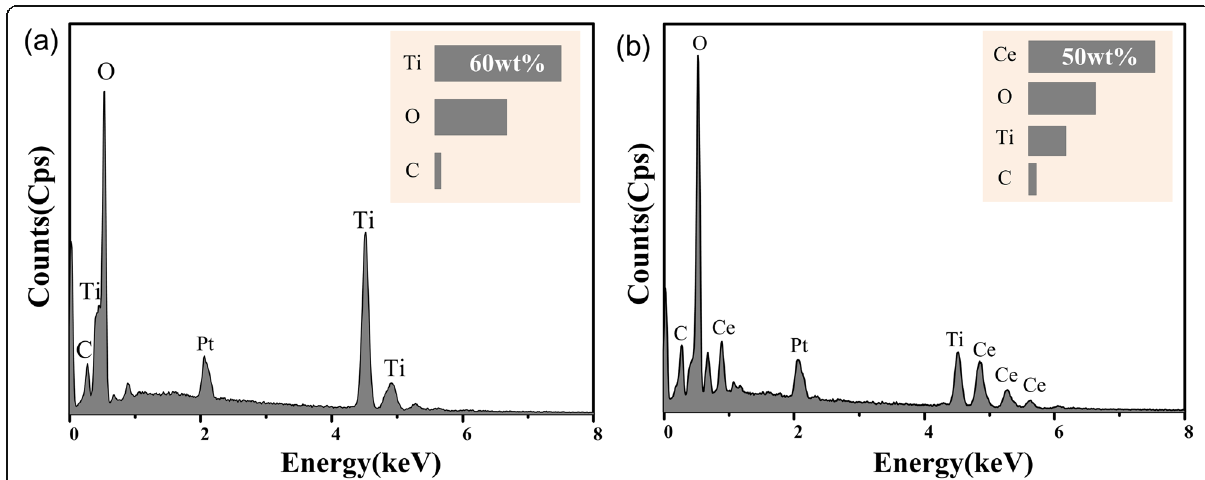
Fig. 6 EDS results of a pure TiO 2 NTs and b CeO 2 /TiO 2 heterojunction, showing the existence of element Ti, Ce, and O after loading Ce(NO 3 ) 3 . The results confirm the successful loading of CeO 2 on the TiO 2